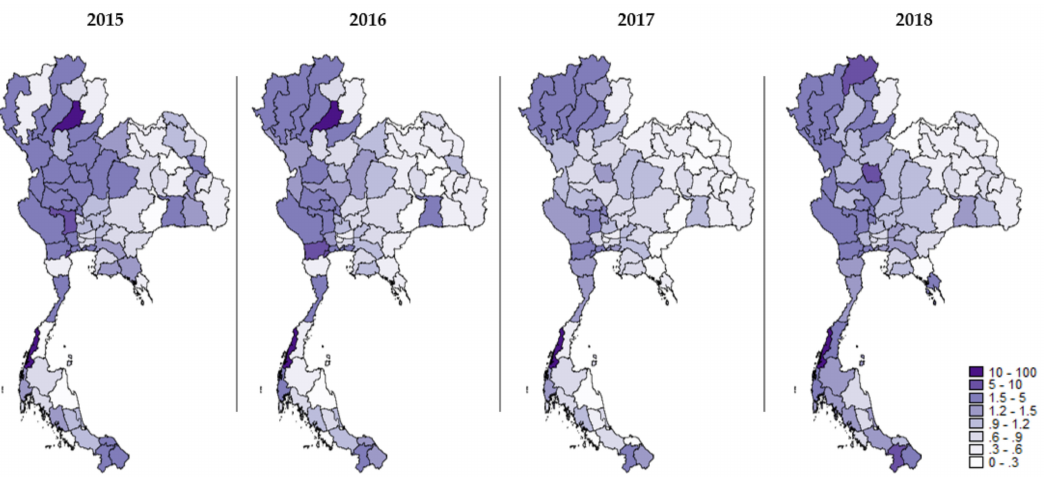
Figure 1. Geographical distribution of the ratio of insured migrants to formal-sector migrants in